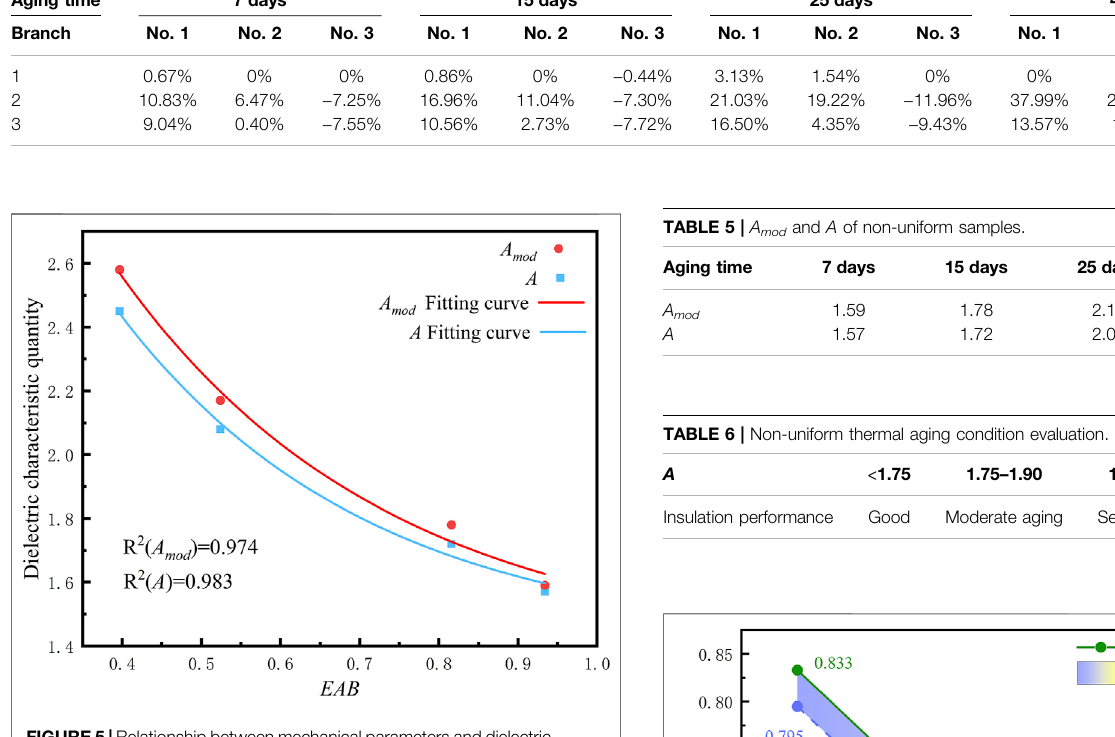
FIGURE5 | Relationship between mechanical parameters and dielectric parameters.